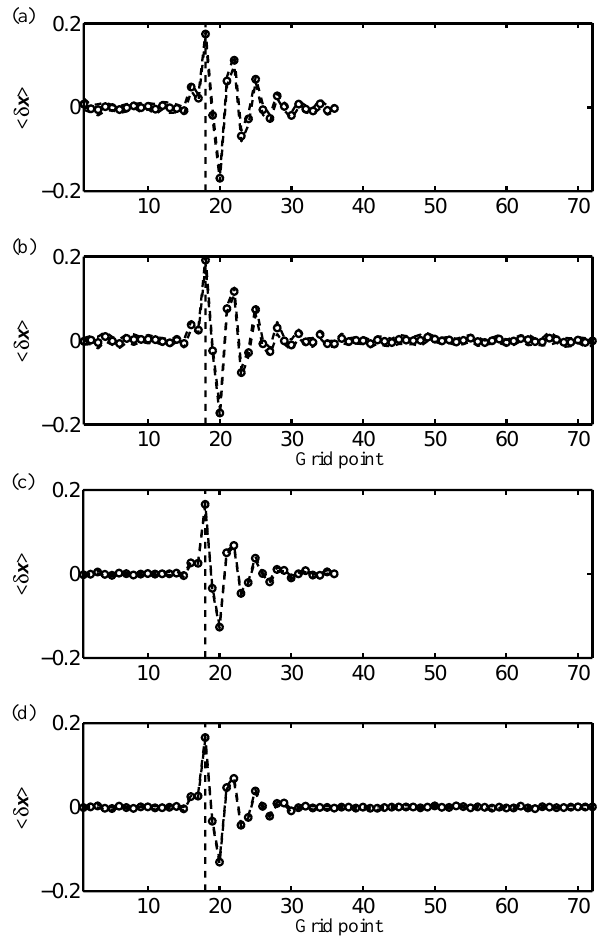
Fig. 1. The response h δ x i of the Lorenz 95 system to a forcing of δf 18 = 1 . 0 with the location of δf 18 indicated by the vertical dashed line. To compare with typical fluctuations during an inte- gration, the standard deviation of a single element of x for δf = 0 is estimated as ∼ 3 . 6 for a = 0. The number of elements in the state vector for (a) and (c) is d = 36 and for (b) and (d) is d = 72. Plots (a) and (b) correspond to the deterministic system with a = 0 and (c) and (d) correspond to the same system with additional stochas- tic noise, a = 2. The integrations are sufficiently long to obtain an accurate response, (2 standard deviations divided by the square root of the number of integrations is smaller than graphical accuracy), which is the same as that reported by Abramov and Majda (2007); see their Fig. 2. The difference between the first 36 points of (a) and (b) or (c) and (d) is not significantly different from zero with this set of integrations. Note that the response to linearly forcing multiple grid points simultaneously is simply the sum of the responses to the decomposed single grid point